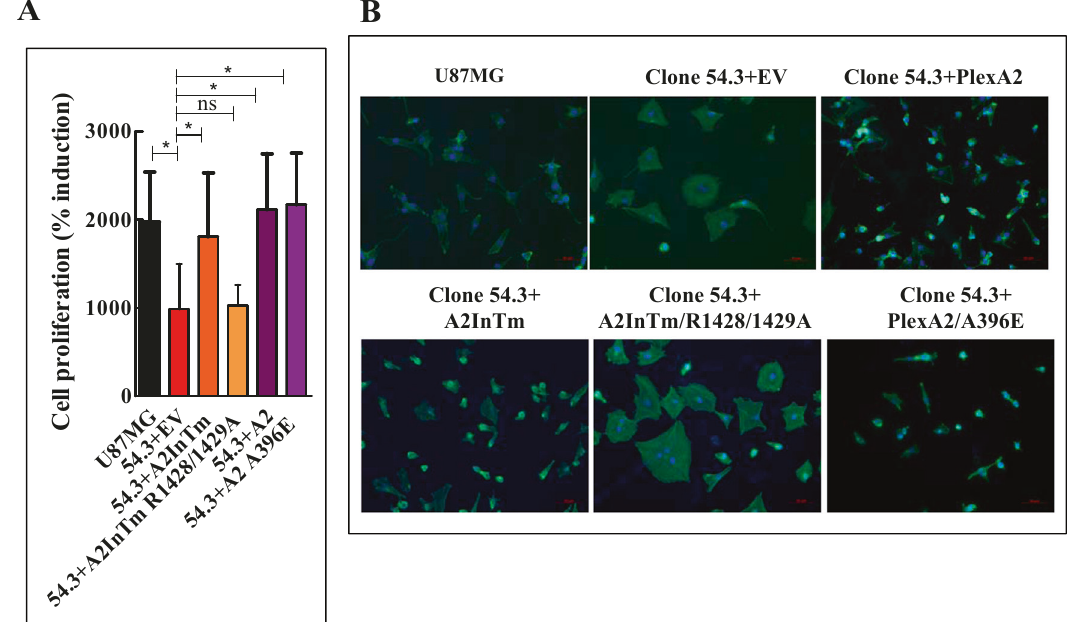
Fig. 8 Point mutations in the GAP domain of plexin-A2 inhibit rescue of cell proliferation by the plexin-A2 intracellular domain while a point mutation at the semaphorin binding site of plexin-A2 has no effect. A U87MG cells, or U87MG clone 54.3 cells infected with either control lentiviruses (EV) or with lentiviruses encoding A2InTm or A2InTm variants containing point mutations in the conserved catalytic arginine residues of the GAP domain (54.3 + A2InTm R1428/1429 A) or the semaphorin binding site located in the extracellular domain of plexin-A2 (54.3 + A2 A396E), were seeded in quadruplicates in 96 well dishes (3 × 10 3 cells/well). Cell proliferation was measured using the WST-1 proliferation assay as described in materials and methods. Induction of cell proliferation was calculated as described under (1B). Data are represented as mean ± SD. Statistical analysis was done using the one-tailed Mann-Whitney test. * P < 0.05, ns: non-speci fi c N = 5. B The indicated cell types were seeded on fi bronectin-coated coverslips and stained with DAPI to visualize cell nuclei (blue) and with fl uorescent phalloidin (green) to visualize actin fi bers. Shown are merged confocal photographs generated using ZEN 2.3